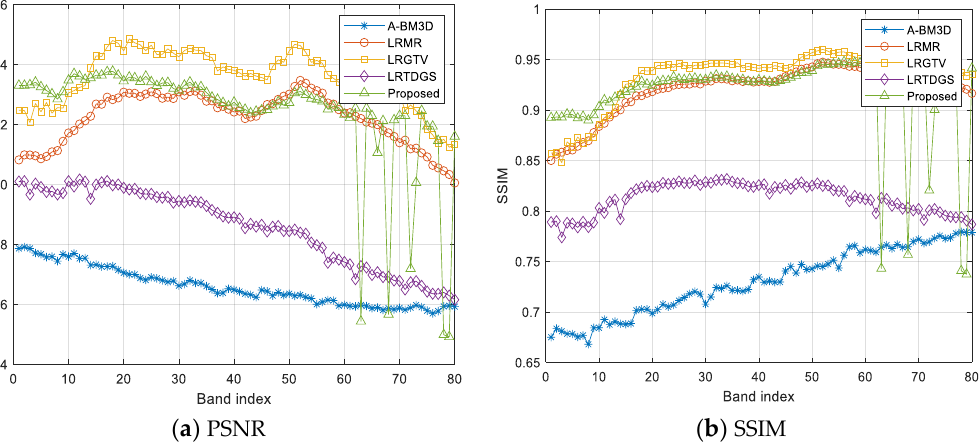
Figure 7. PSNR and SSIM values of restored results by different methods on Pavia data (G = 0.10, S = 0.10).